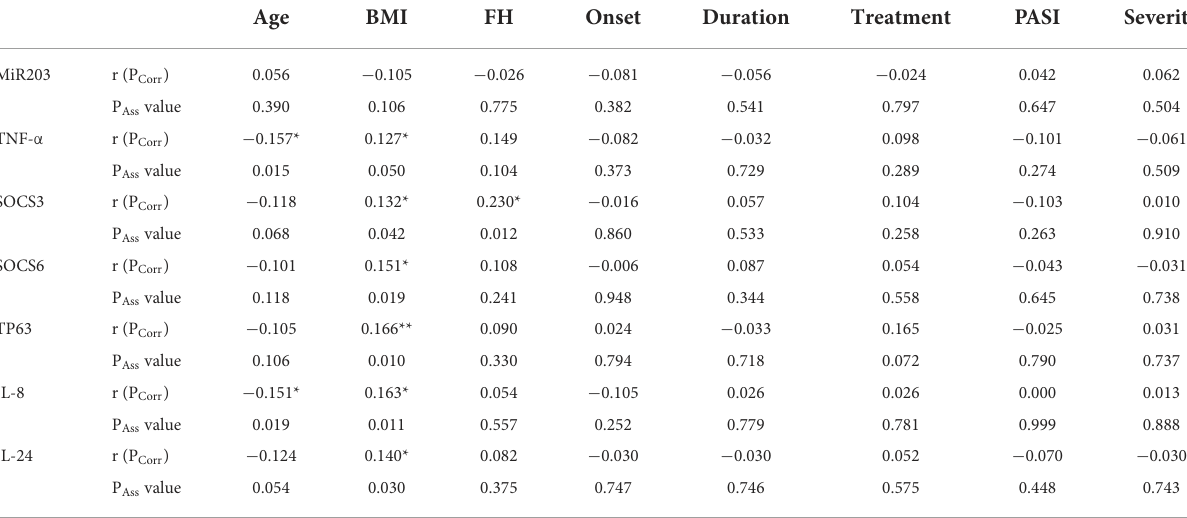
TABLE 3 Correlation between the baseline and clinical information for research participants with psoriasis, miR-203, and its target genes. Age BMI FH Onset Duration Treatment PASI